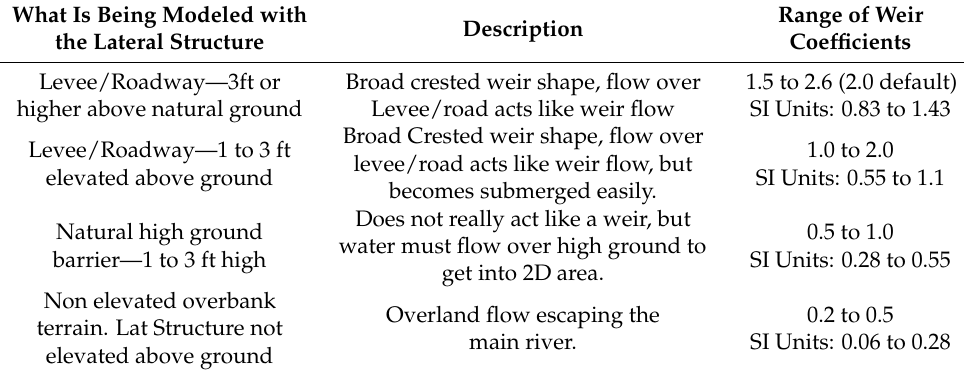
Table 1. Lateral weir